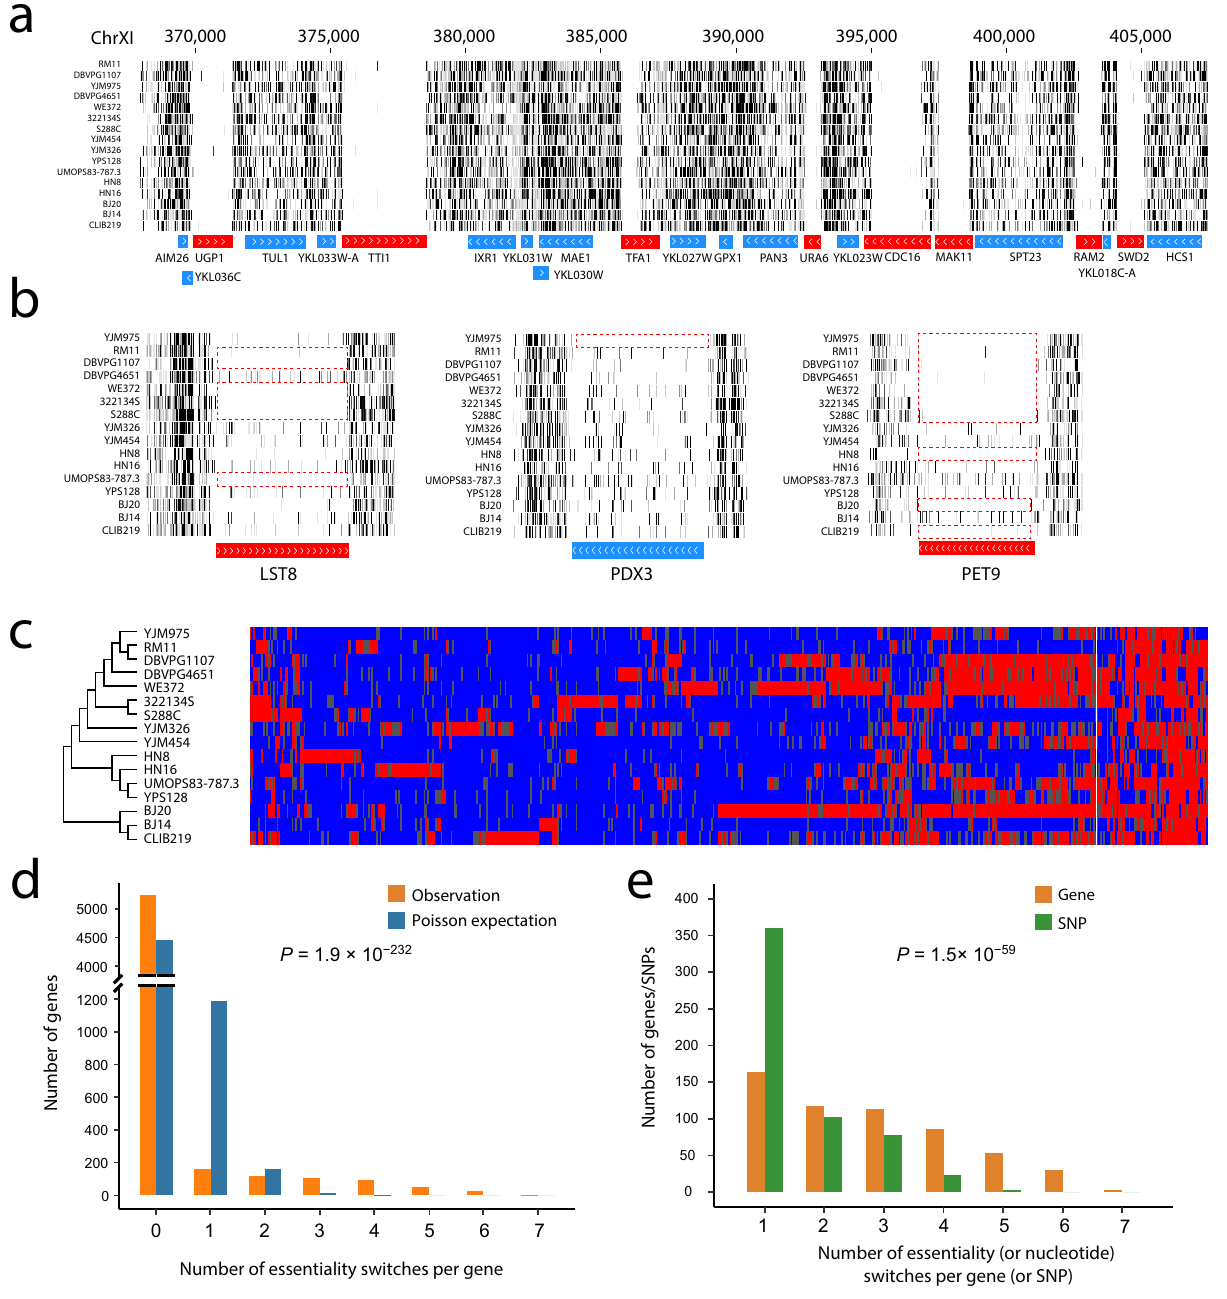
Number of essentiality (or nucleotide) switches per gene (or SNP) Fig. 2 Gene essentiality polymorphism in yeast. a A typical example of a genomic region with transposon insertions in each strain. Stain names are shown on the left side of the panel. Eight annotated essential genes (red bars) have part or all of their coding regions virtually transposon-free, while the 15 annotated nonessential genes (blue bars) tolerate transposons in all of their coding regions. Horizontal bars mark gene locations, with gene names provided below the bars and white arrows indicating transcriptional directions. Each vertical gray line represents one transposon insertion and the darkness of the line is proportional to the number of sequencing reads. b Three examples of gene essentiality polymorphism in the 16 yeast strains. The red boxes highlight strains where the gene is (virtually) transposon-free. c Gene essentiality polymorphism in the 16 strains. Each column represents a gene while each row represents a strain. Red, essential genes; blue, nonessential genes; gray, essentiality undetermined. The phylogeny of the 16 strains as in Fig. 1b is shown on the left, but the branches are not drawn to scale. d Distribution of the observed number of essentiality changes per gene along the phylogeny of the 16 strains, compared with the Poisson distribution with the same mean. P -value is from a one-tailed chi-squared test comparing the variance of the observed distribution with the corresponding Poisson variance. e Distribution of the observed number of essentiality changes per gene along the 16-strain phylogeny for the 567 genes exhibiting essentiality polymorphism, compared with the corresponding distribution of the number of nucleotide switches per SNP along the phylogeny for 567 randomly picked SNPs with levels of polymorphism matching levels of gene essentiality polymorphism. P -value from the two-tailed Wilcoxon signed-rank test that compares the mean ranks of the two distributions is presented. We perform 1000 replications of sampling of 567 SNPs and fi nd P < 2.9 × 10 − 52 in every replication. Source data are provided as a Source Data fi